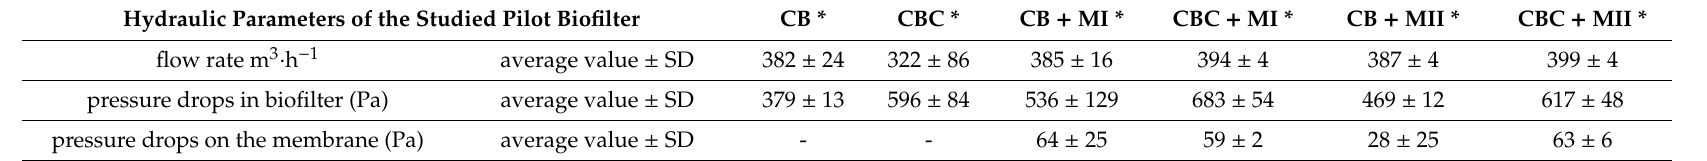
Table 3. Hydraulic parameters of the studied pilot